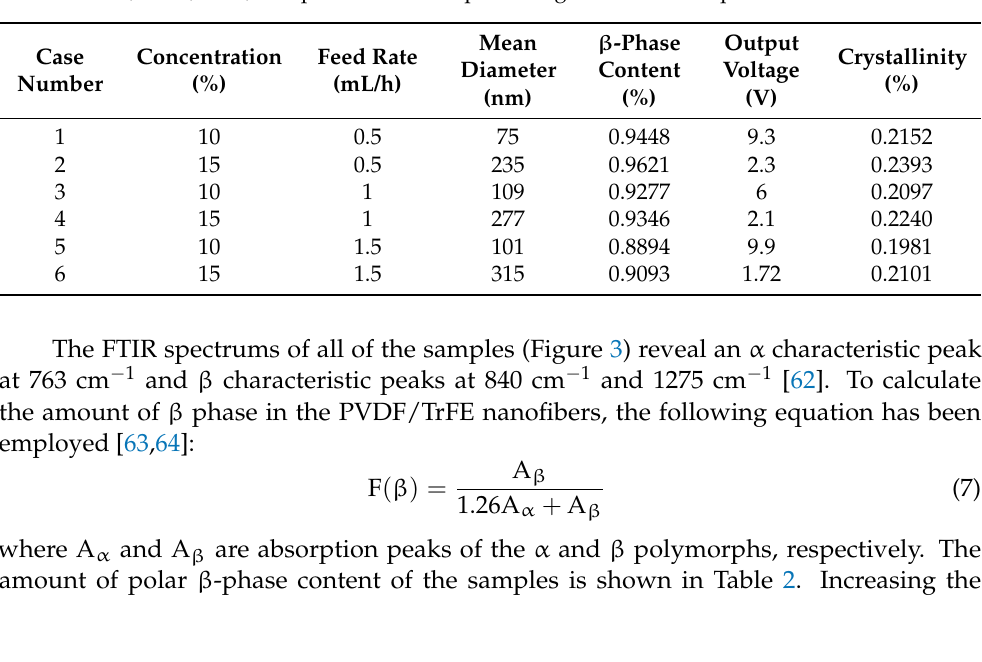
Figure 2. SEM image and corresponding histograms of ( a ) case number 1, ( b ) case number 2, ( c ) case number 3, ( d ) case number 4, ( e ) case number 5, and ( f ) case number 6. Table 2. SEM, FTIR, DSC, and piezoelectric output voltage results of